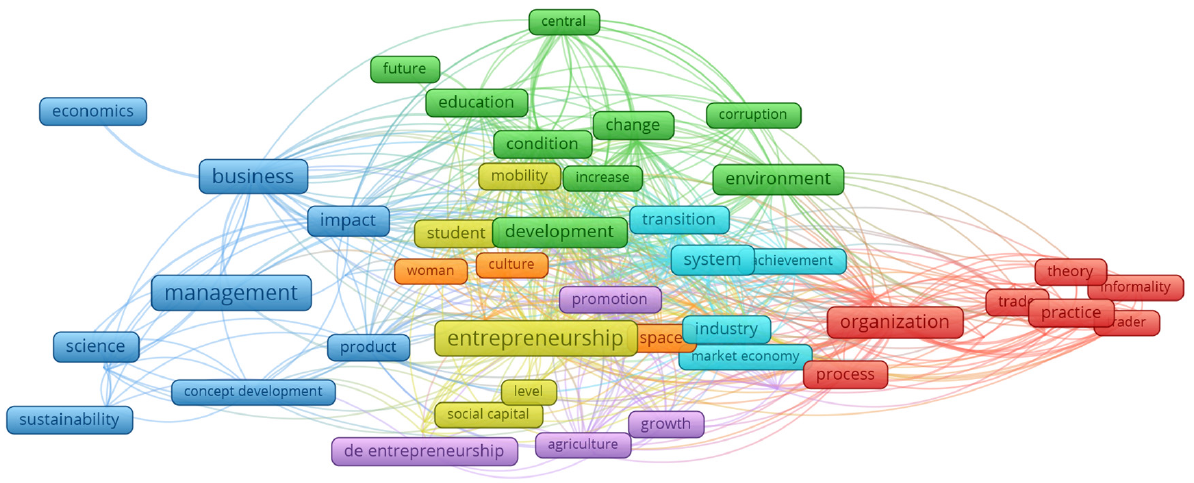
Figure 2. Most encountered words and word networks in scientific publications’ content.